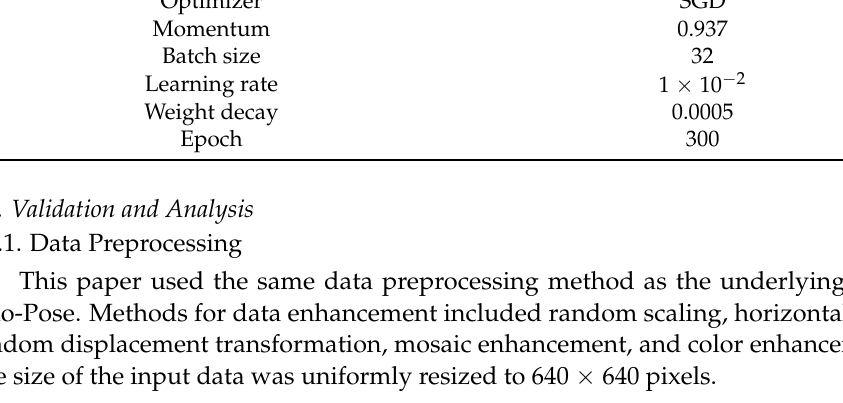
Table 1. Hyperparameter Settings.